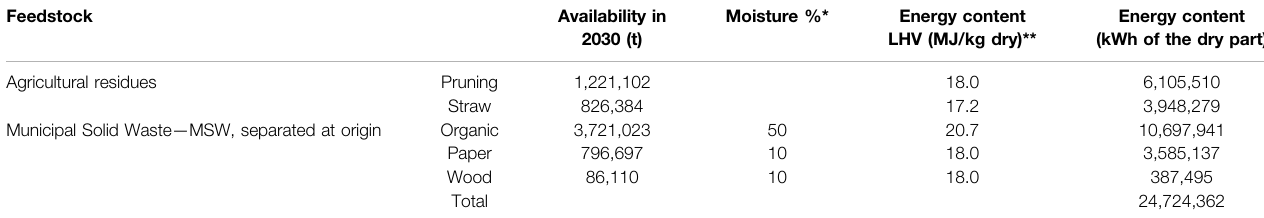
TABLE 4 | Technical potential of the feedstock in 2030. Feedstock